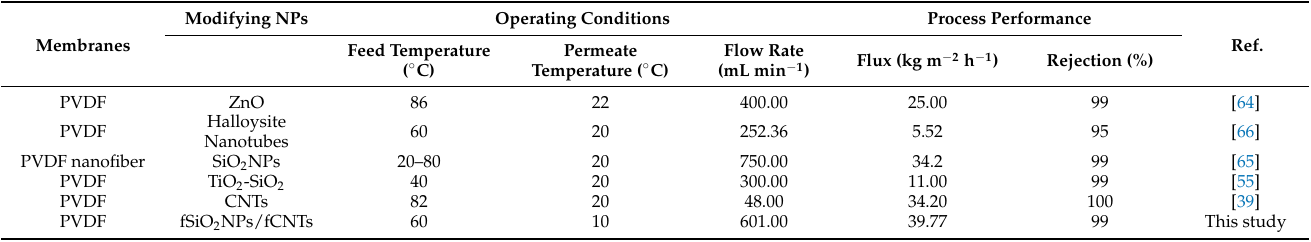
Table 4. Comparison of nanoparticle-modified PVDF membranes for water desalination in DCMD.